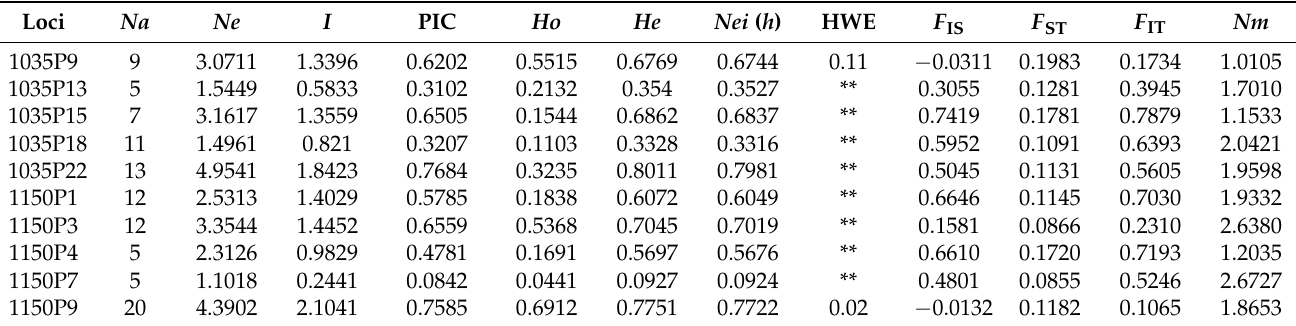
Table 3. The genetic diversity and genetic variation of EST-SSR loci. ** represent deviating from Hardy-Weinberg equilibrium (HWE) at the level of p <